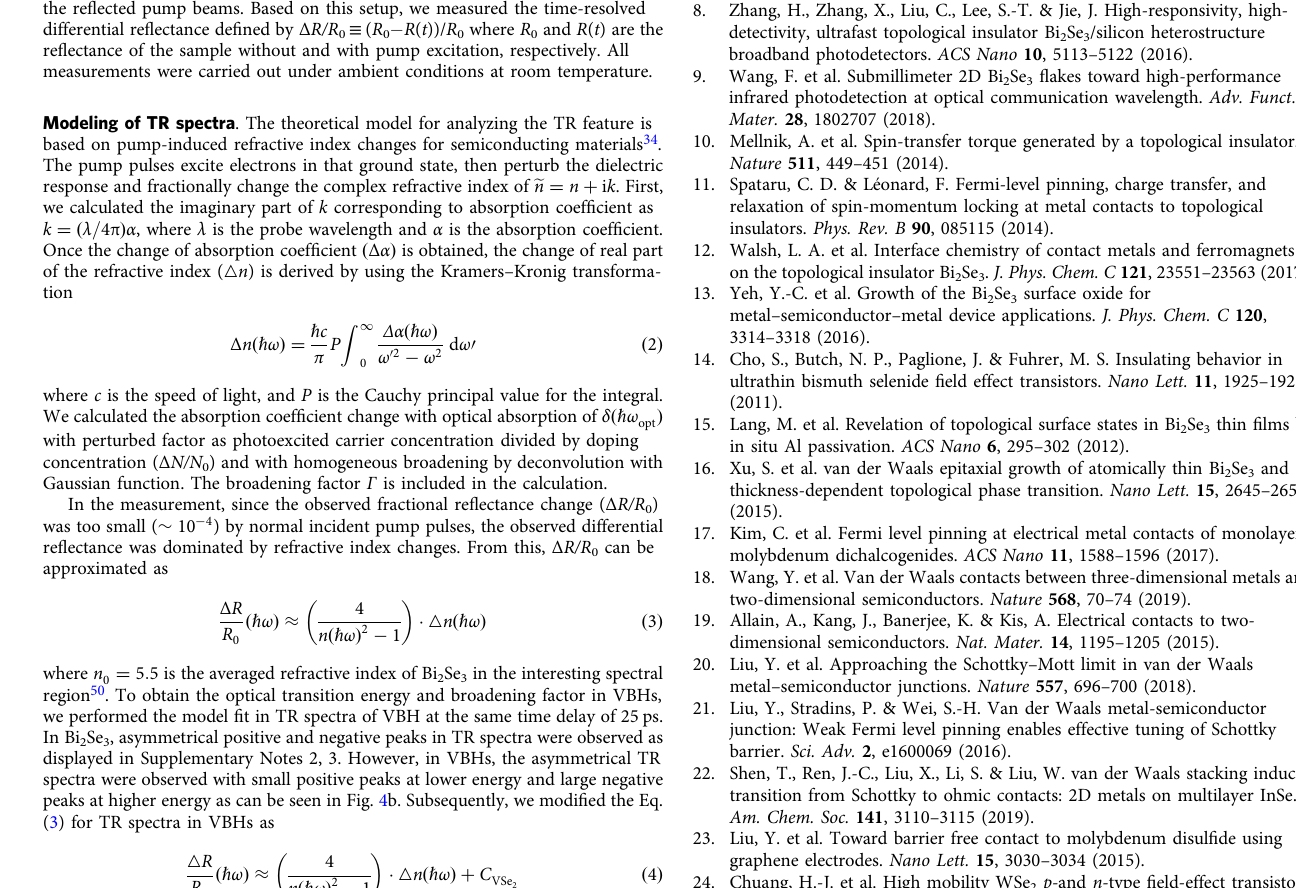
became larger with the increase of VSe 2 2